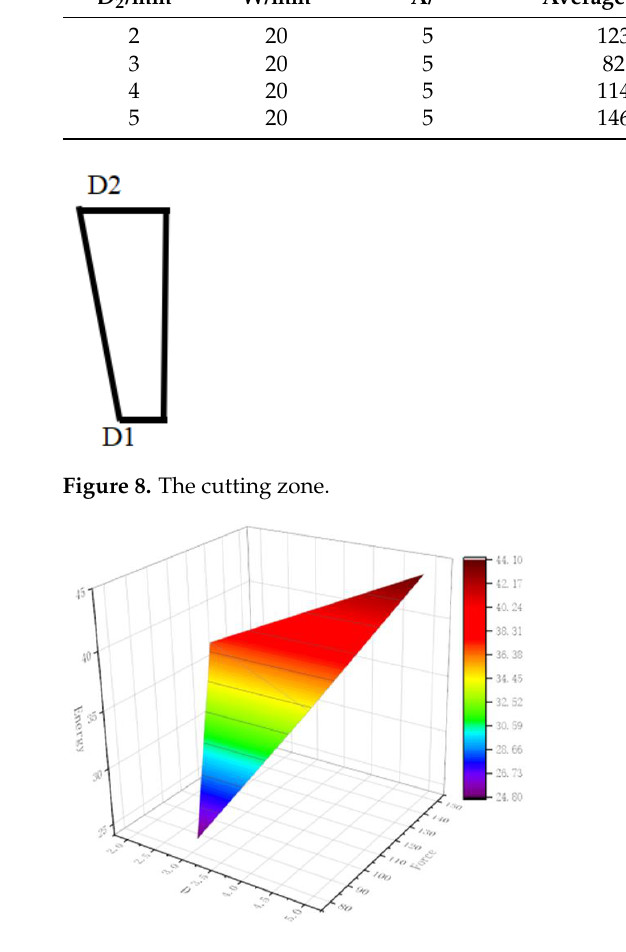
Figure 9. Three-dimensional figure of D–energy–force. Table 4. Influence of W on material properties. Table 3. Influence of D on material properties.